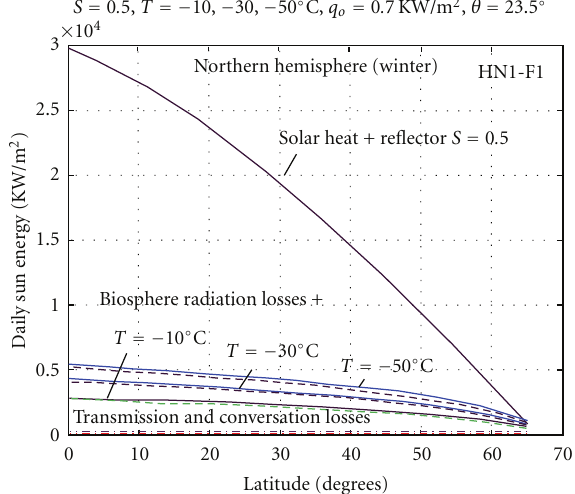
Figure 13: Daily heat balance through 1m 2 of dome during the coldest winter day versus Earth’s latitude (Northern hemisphere example). Data used for computations (see (6)–(14)): temperature